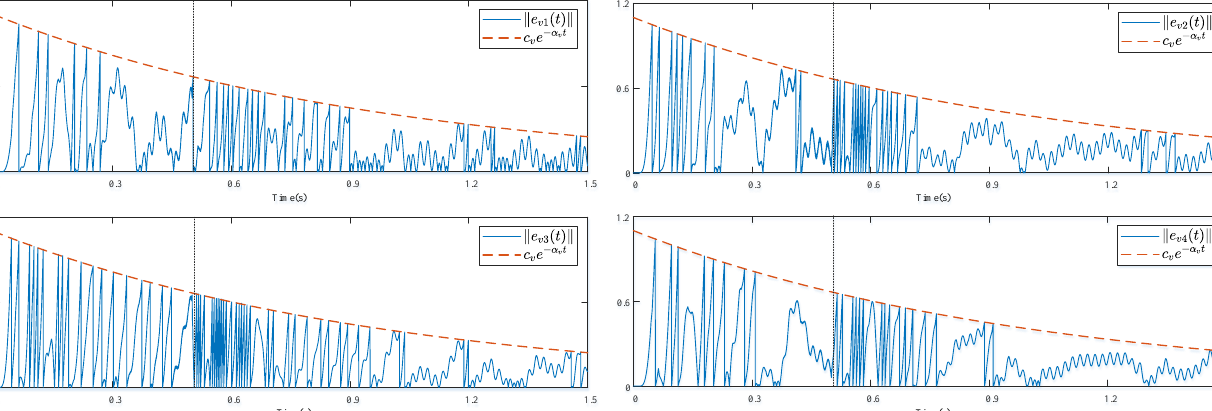
Figure 7. Voltage trigger state diagrams for each DG.